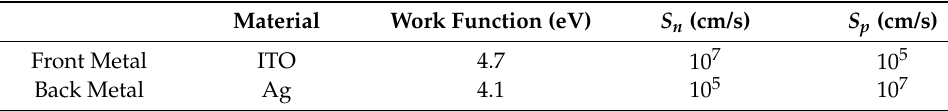
Table 2. Main factors of the top and back metal contacts [41].